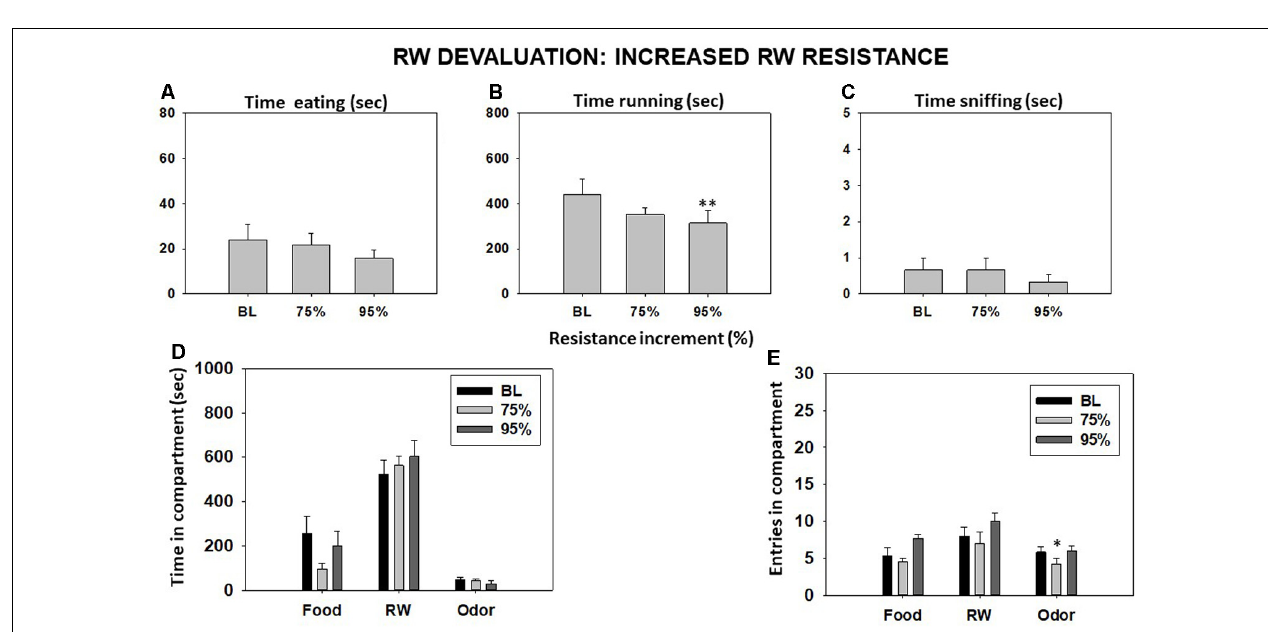
FIGURE 6 | Effect of increasing running wheel (RW) resistance on mice behavior in the T-maze task. Bars represent mean ( ± SEM) of time (s) eating (A) , running (B) , and sniffing the neutral odor (C) ; time spent in each compartment (D) ; and compartment entries (E) during a 15-min session. Bars represent mean ± SEM of accumulated seconds or number of entries. ∗ p < 0.05, ∗∗ p < 0.01 significantly different from BL.